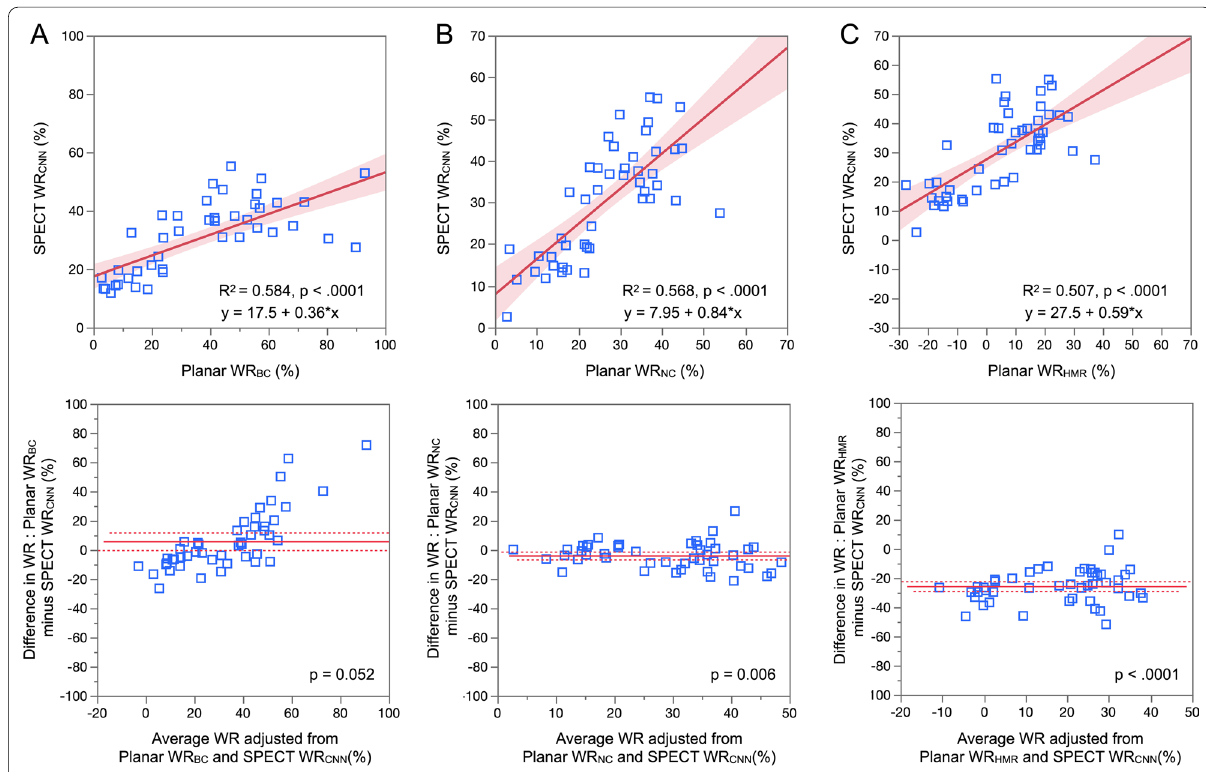
Fig. 4 Relationships between washout rates calculated from SPECT images using CNN and planar images using conventional methods: linear regression lines (upper panels) and Bland–Altman plots (lower panels). SPECT WR vs. planar WR BC ( A ), planar WR NC ( B ), and planar WR HMR ( C ). Shaded area, confidence of fit; dotted lines, 95% confidence